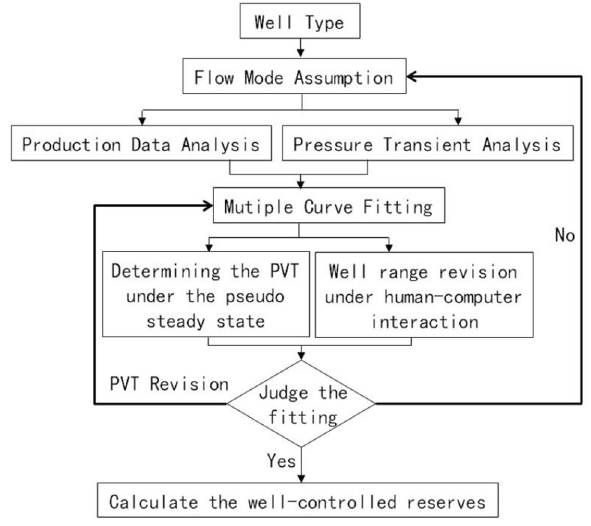
Fig. 3 The workflow of well-controlled reserves